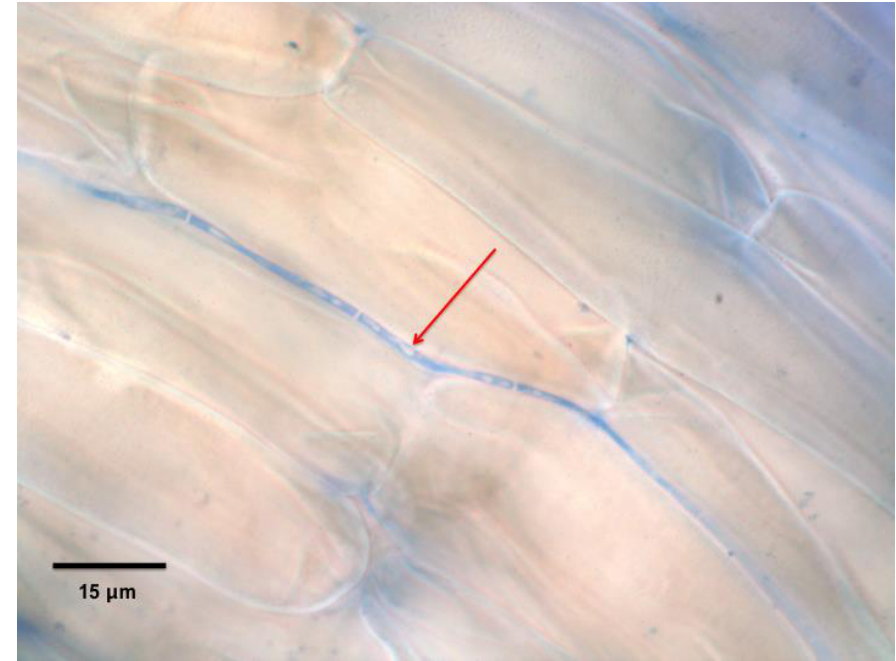
Figure 3. Root cortex cells in the primary Poa annua seedling root 10 days after seeds were inoculated with a Curvularia sp. showing an intercellular fungal hypha (indicated with arrows) stained with aniline blue (0.1%).